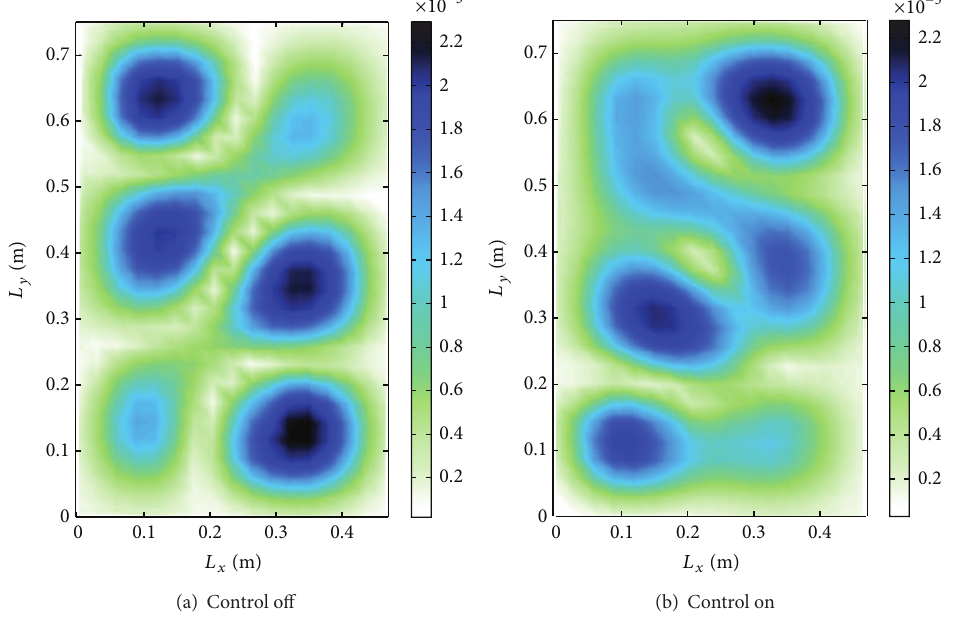
Figure 20: The WSSG field with the plate excited at the fifth mode natural frequency, with control off and